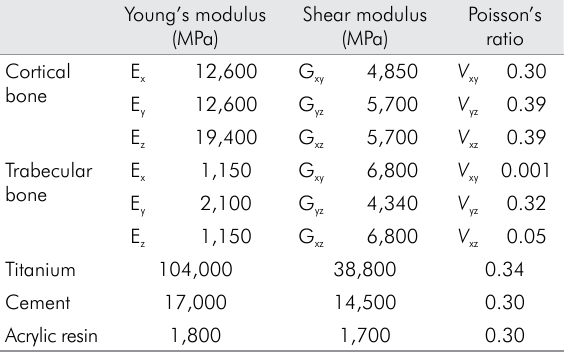
Table 1. Mechanical properties of the materials included in finite element analysis.